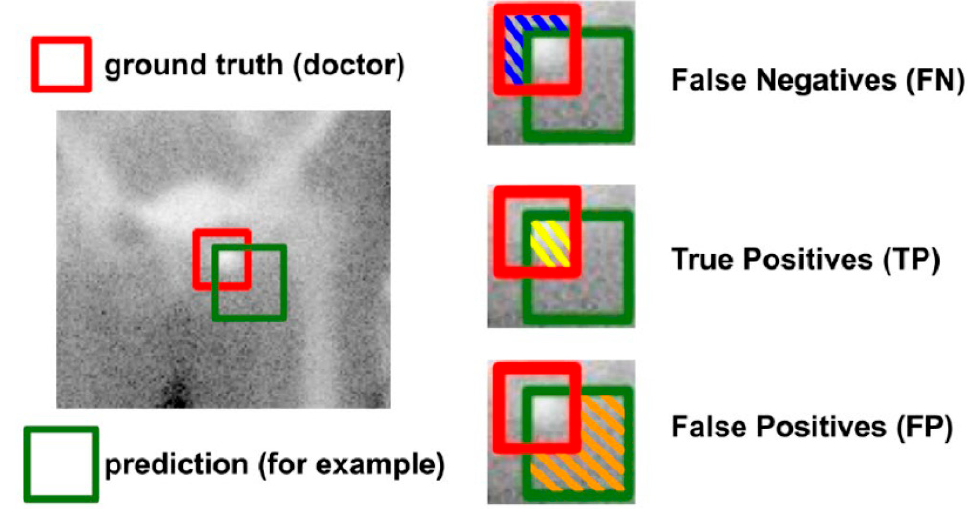
Figure 7. Dice Similarity Coefficient.